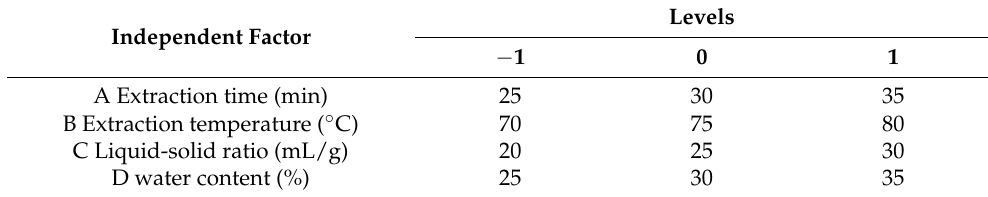
Table 2. Independent factors and their levels.